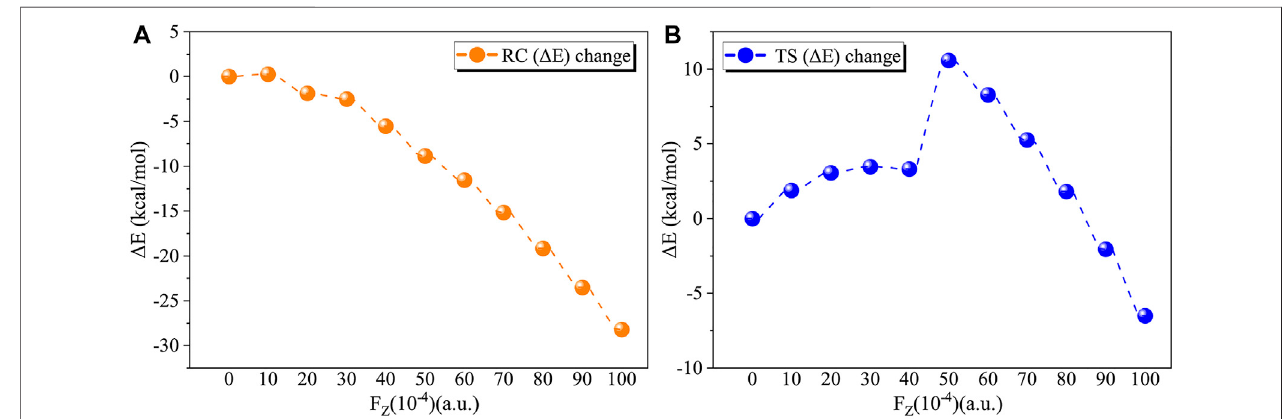
FIGURE 4 | (A) Variation in the relative electron energy of the reactants (RC) with the electric fi eld strength. (B) Variation in the relative electron energy of the transition states (TS) with the electric fi eld strength.